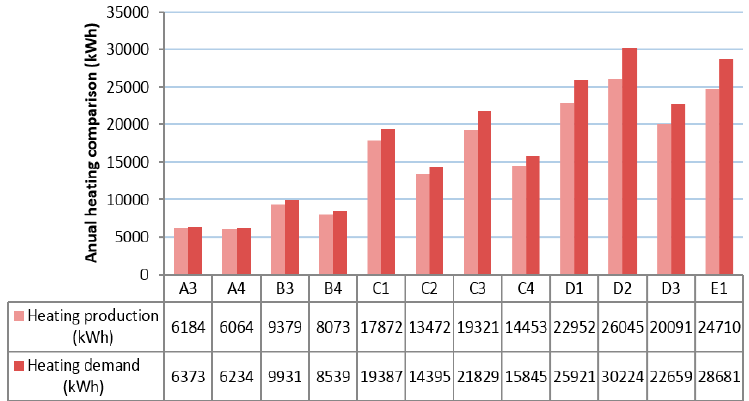
Figure 9. Annual heating comparison for the different climatic zones.